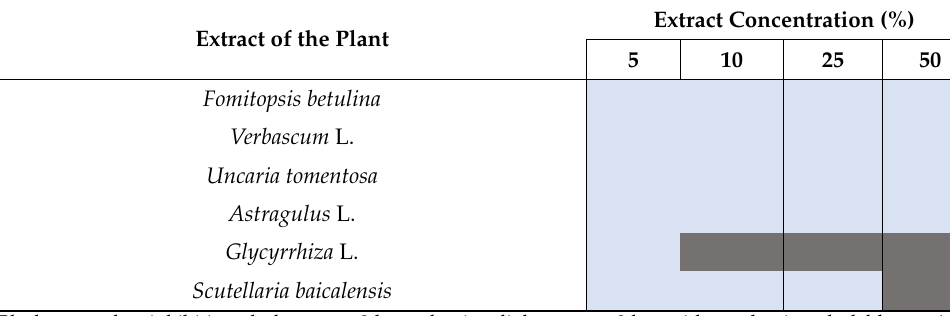
Extract Concentration (%)